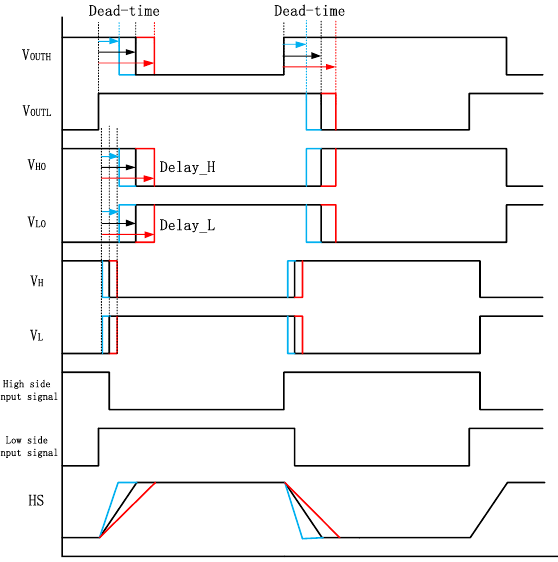
Figure 4. The ideal waveform of adaptive dead-time control circuit.